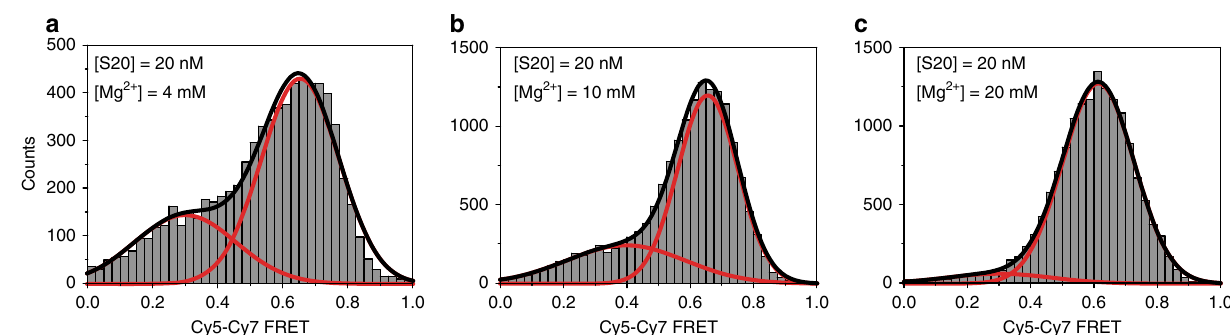
Fig. 2 S4-S16 complexes sample the non-native conformation in physiological Mg 2+ . Populations of native (high FRET) and fl ipped (low FRET) complexes containing 5 ′ domain h3-Cy7, S4-Cy5, and S16-Cy3 in 20 nM S20, at different Mg 2+ concentrations. Histograms for Cy5-Cy7 FRET are based on a 68, b 97, and c 105 trajectories from three-color smFRET experiments as in